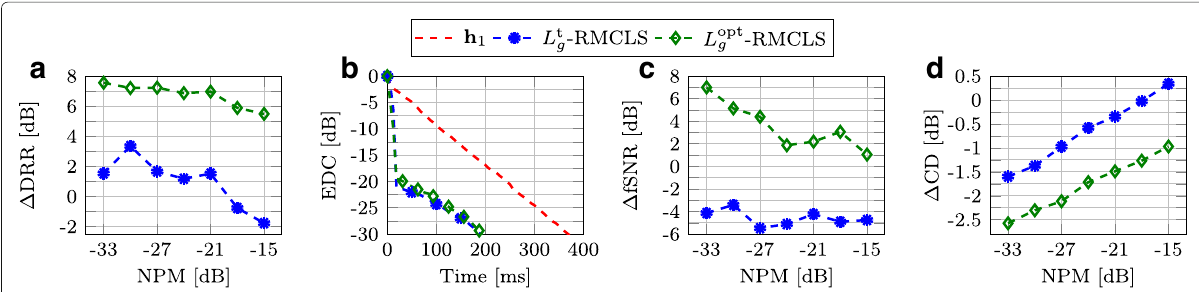
Fig. 6 Performance of RMCLS using the conventional filter length L t g and the optimal intrusively determined reshaping filter length L opt g for acoustic system S 1 in terms of a (cid:3) DRR, b EDC for an NPM of − 33 dB, c (cid:3) fSNR, and d (cid:3)